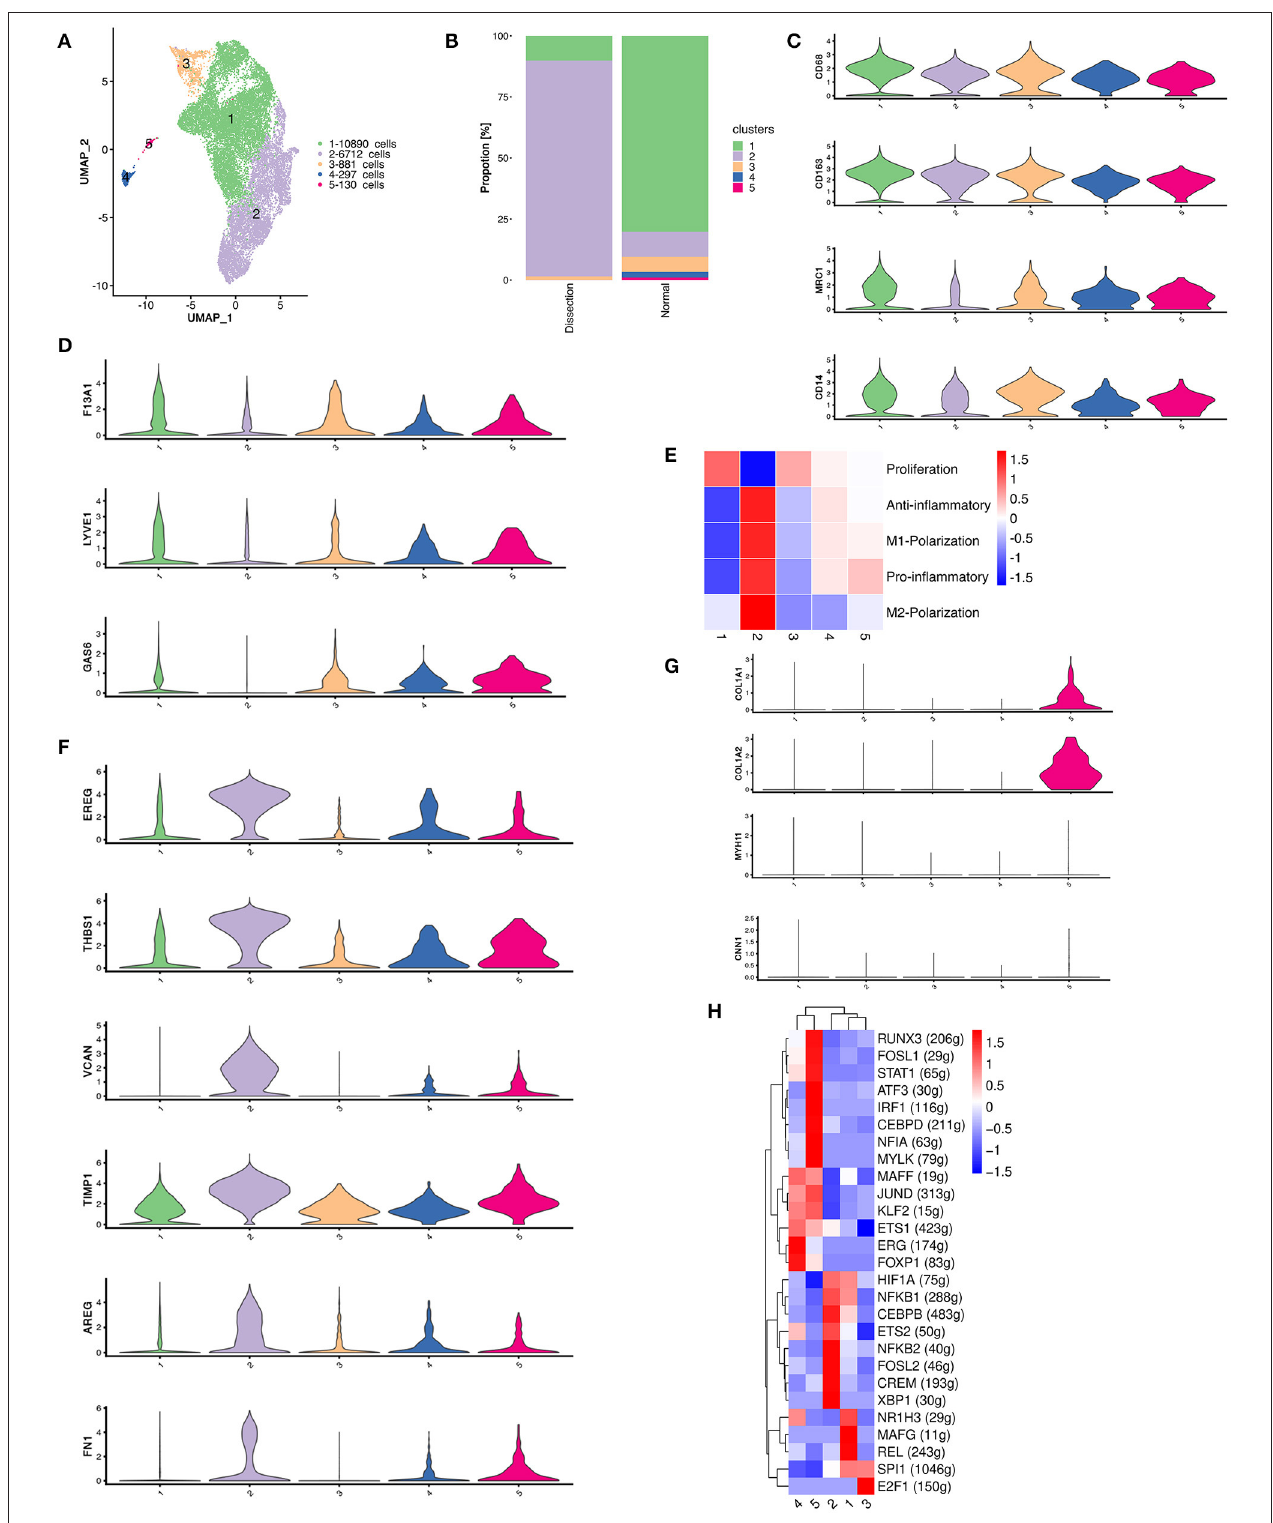
FIGURE 2 | The heterogeneity of macrophages between normal and dissected aorta tissues. (A) A UMAP plot of 18,910 myeloid cells reclustered into 5 clusters. (B) The sample origin of myeloid cells showing differences in the distribution of cell clusters between the two groups. (C) Violin plots displaying the expression of marker genes in macrophages and dendritic cells. (D) Violin plots displaying the expression of marker genes of aortic resident macrophages. (E) Heatmap displaying the